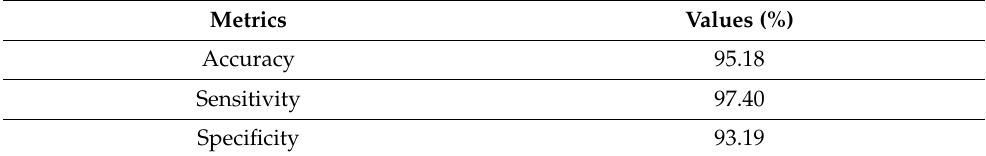
Table 3. Accuracy, Sensitivity, and Specificity of the boosting ensemble